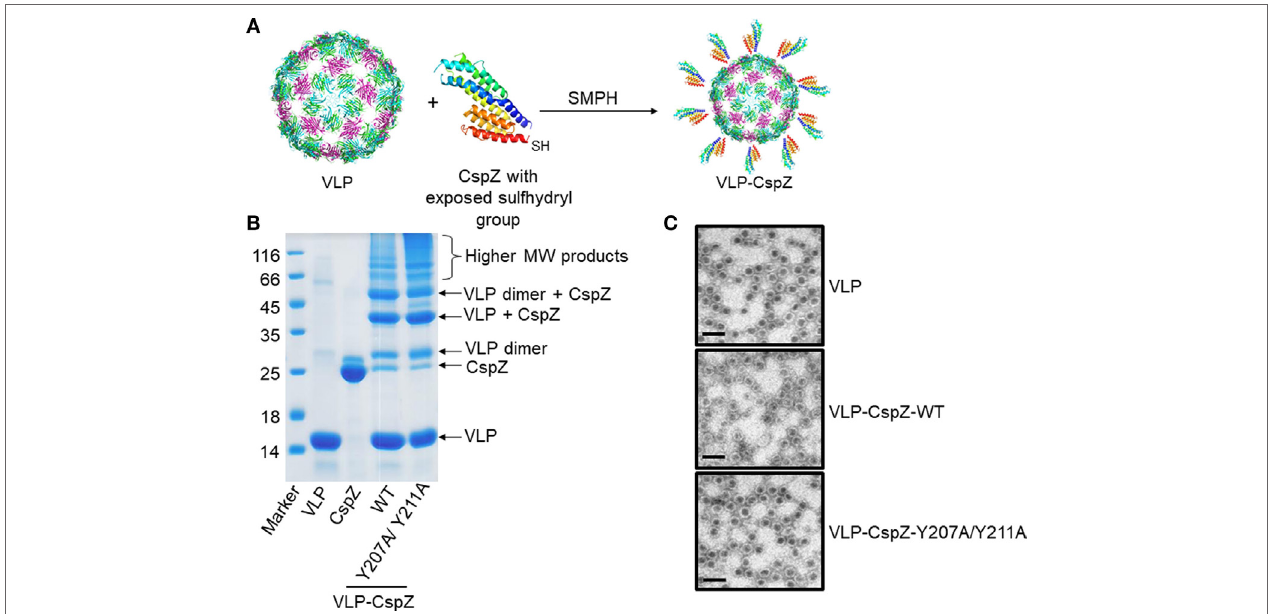
FigUre 1 | The generation and verification of virus-like particle (VLP)-conjugated CspZ proteins. (a) Purified wild-type CspZ or CspZ-Y207A/Y211A with an exposed a sulfhydryl group and virus-like particles (“VLP”) generated from Q β phage were mixed with Succinimidyl 6-((beta-maleimidopropionamido) hexanoate) (“SMPH”) to crosslink VLP and each of these CspZ proteins (“VLP-CspZ”). (B) The sizes and purity of each conjugate were determined by a 15% SDS-PAGE. The molecular marker (kD) is in lane 1, followed by preparations of VLP (lane 2, “VLP”), CspZ (lane 3, “CspZ”), VLP-CspZ (lane 4, “VLP-CspZ-WT”), and VLP-CspZ- Y207A/Y211A (lane 5, “VLP-CspZ-Y207/Y211A”). The arrows identify known protein products as indicated. (c) Representative images of VLPs generated in this study. EM analysis of freshly purified VLP (“VLP”), VLP-CspZ (“VLP-CspZ-WT”), or VLP-CspZ-Y207A/Y211A (“VLP-CspZ-Y207A/Y211A”) following negative staining with 1% uranyl acetate. Scale bar = 100